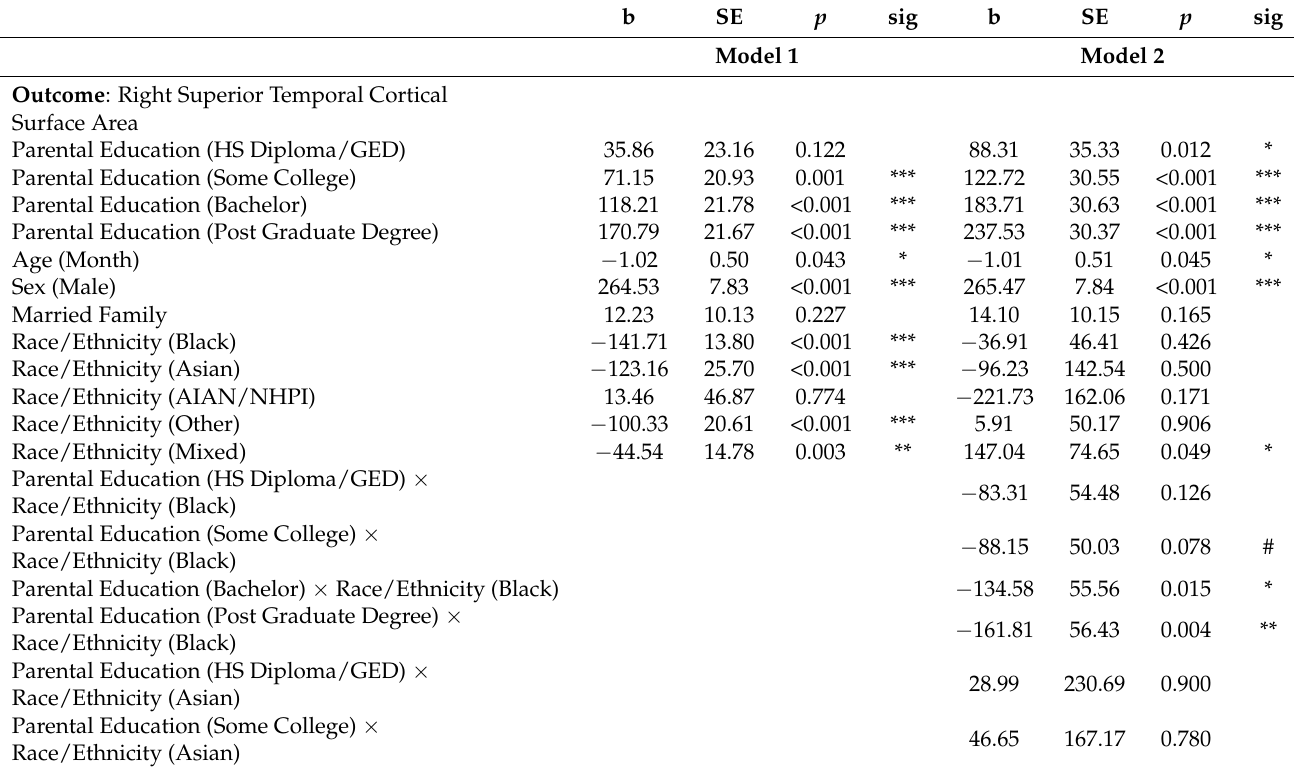
Table 3. Summary of mixed-effects regression models on the association between parental education and the right superior temporal cortical surface